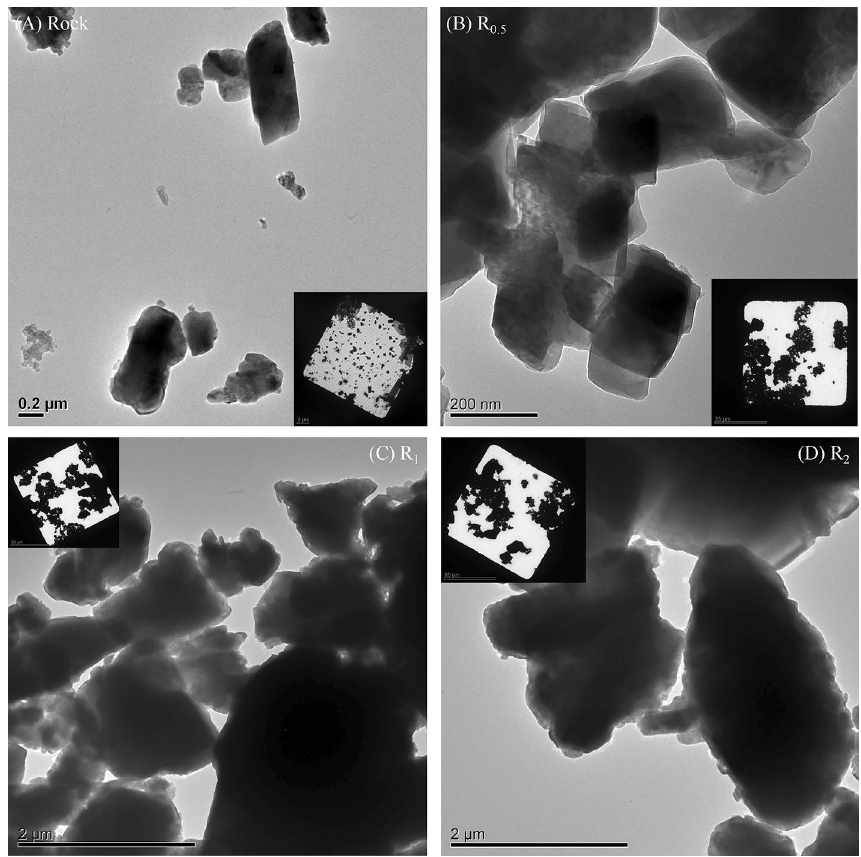
Figure 2. TEM square view and individual particles images. ( A ) Raw rock; ( B ) R 0.5 : rock top layer; ( C ) R 1 : rock middle layer; and ( D ) R 2 : rock bottom layer from rock